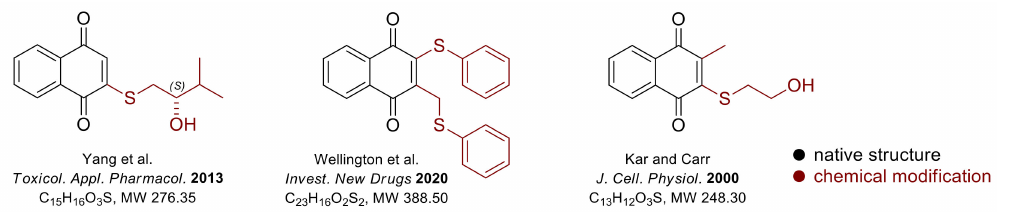
Figure 2. Structure of vitamin K 3 derivatives showing promising activity against BC cell lines